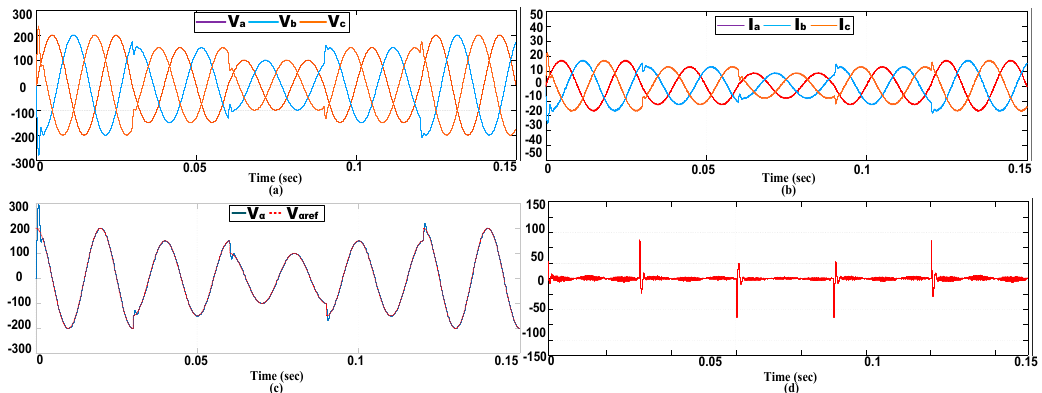
Figure 12. Simulation results with the H ∞ robust controller in transient condition. ( a ) Output voltage, ( b ) Load current, ( c ) α -frame voltage waveform, ( d ) Voltage tracking error.